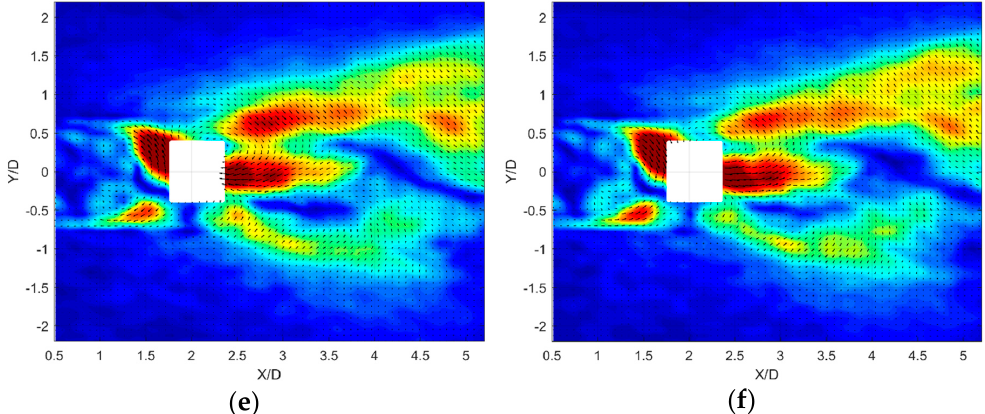
Figure 8. POD spatial modes: ( a ) S A = 1, ( b ) S B = 1, ( c ) S A = 2, ( d ) S B = 2, ( e ) S A = 3, ( f ) S B = 3. Color scale represents magnitude and is normalized to a common factor across all subfigures.